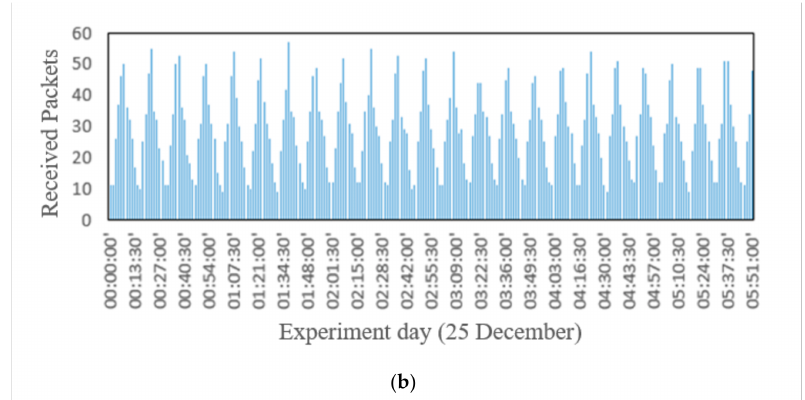
Figure 6. Packet reception by the IoT server on di ff erent days. ( a ) Number of packets received in a 1.5-min interval from all the nodes for a day (15 December 2017). ( b ) Number of packets received in a 1.5-min interval from all the nodes for six hours (25 December 2017).